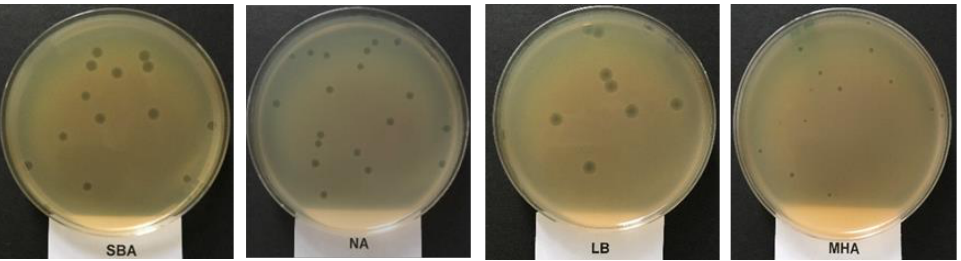
Figure 1. The formation of plaques of the phage UAE_MI-01 on different agar media using Escherichia coli O157:H7 NCTC 12900 as the propagation host (SBA: soyabean casein digest agar; NA: nutrient agar; LBA: Luria-Bertani agar; MHA: Muller Hinton agar). Table 2. Effect of different complex media on the viability and propagation of the phage UAE_MI-01. Type of Medium